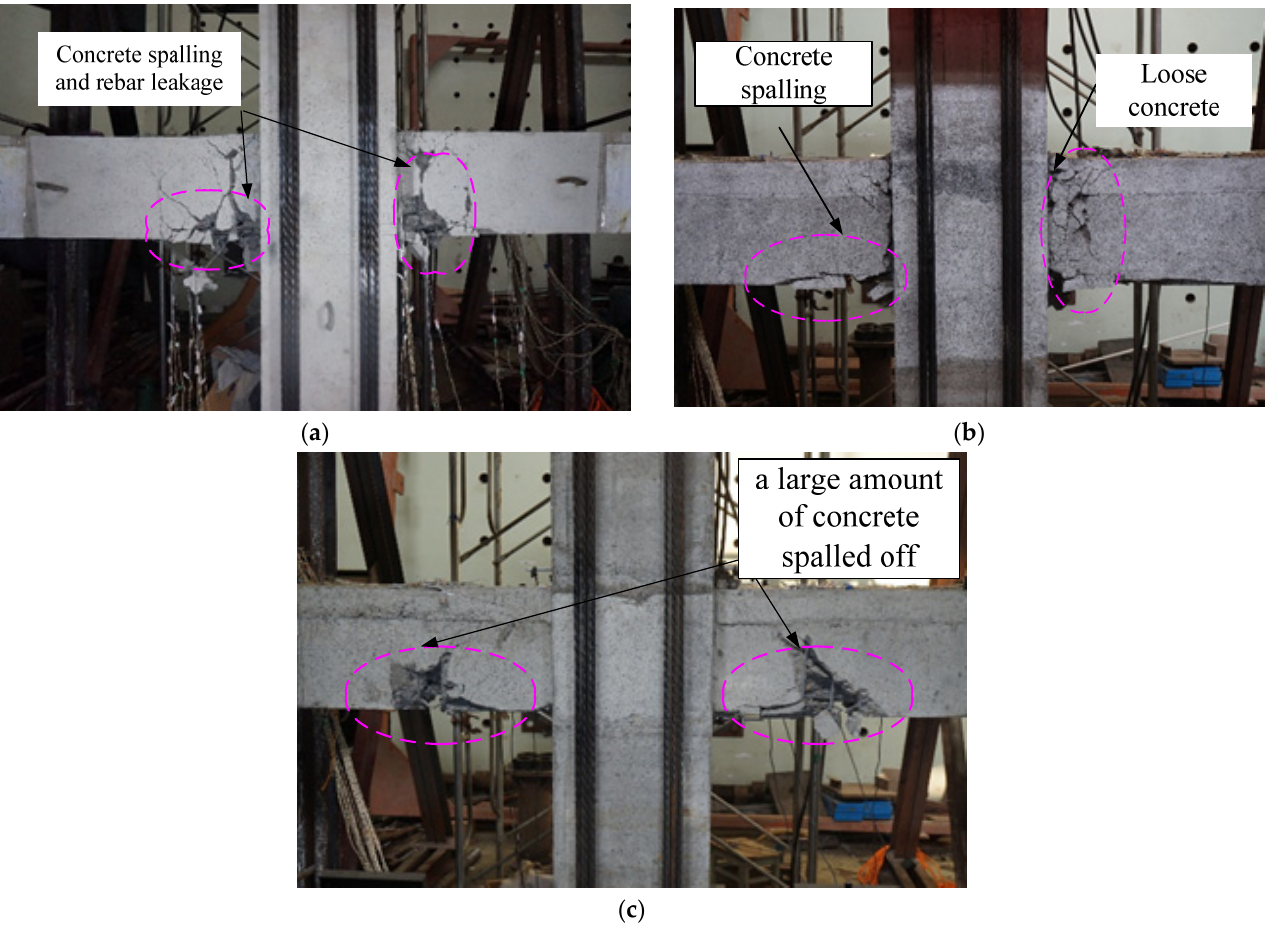
Figure 10. The final destruction pattern of the joints. ( a ) XJ. ( b ) YZ1. ( c ) YZ2. First, we carried a single load of 0.034%, 0.069%, and 0.10% drift ratio on YZ1. When the 0.069% drift ratio was loaded, a crack with a width of 0.02 mm appeared in the lower part of the beam at a distance of 11 cm from the beam-column interface. When loaded to a drift ratio of 0.10%, bending cracks that developed from the bottom to top appeared at the bottom of the beam at 6 cm, 38 cm, and 60 cm from the beam-column interface, respec- tively. After loading to the drift ratio three times per stage, the cracks gradually developed until the specimens were damaged. When loading at a 4.25% drift ratio, the concrete at the beam end was continuously crushed, and the lower concrete continuously fell. It could be observed that while the lower longitudinal reinforcement bends when compressed, the concrete inside the core beam was also crushed, and the above-mentioned diagonal cracks continued to widen, forming a major diagonal crack. When the 4.25% drift ratio was re- peatedly loaded for the second time, the load value was significantly reduced, the speci- men was damaged, and the loading was stopped. The specimen YZ2 failure pattern was almost similar to the YZ1 specimen. When loaded to a drift ratio of 3.5%, a large amount of concrete under the beam spalled off. The